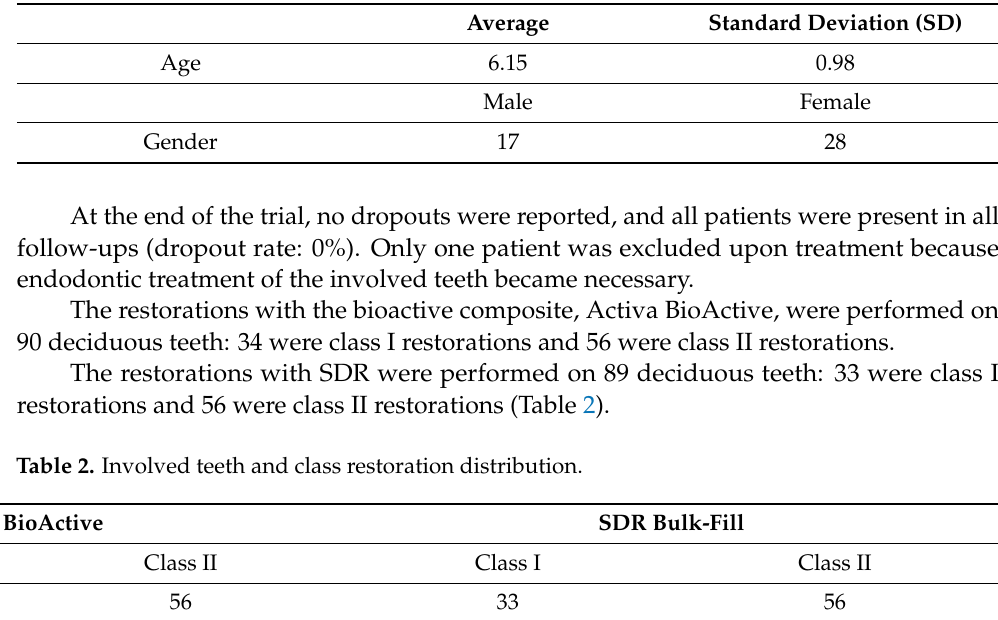
Table 1. Age and gender distribution.